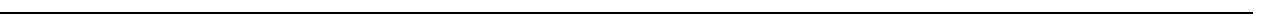
Fig. 2 USP48 cleavage rates on H2ABRCA1ub are modulated by an auxiliary ubiquitin. a An auxiliary ubiquitin activates USP48 processivity. Gel-based assay to measure USP48 cleavage of H2A BRCA1ub . TAMRA Ub was used as readout. Cleavage was recorded under several different substrate and enzyme concentrations. Four (stacked) gels are shown as an example (Supplementary Fig. 3 for all gels). b Quanti fi cation of ( a . Four out of 11 different conditions shown as an example (Supplementary Fig. 3 for full panel). Solid lines show fi t obtained by global fi tting of all 11 quanti fi ed time courses and binding data to the model de fi ned in e using Kintek Explorer . c USP48 binds with similar af fi nities to ubiquitinated and unmodi fi ed NCP. USP48 is titrated to 50 nM of unmodi fi ed NCP or NCP BRCA1ub and analyzed by native gel-shift assays. A Kd of 1 µ M is estimated. d USP48 binds nucleosomes of different ubiquitination status with the same af fi nities. Binding of USP48 to H2A BRCA1ub , H2A BRCA1ub1 , and unmodi fi ed nucleosomes measured by surface plasmon resonance. Nucleosomes were immobilized on the surface. Normalized RU values of 10 successive injections of different USP48 concentrations are fi tted by a one- phase binding model using GraphPad Prism (raw data in Supplementary Fig. 3b). K d and SE of the fi t are indicated. e USP48 cleaves H2A BRCA1ub in nucleosomes 50 – 150 times faster than when auxiliary ubiquitin is present. Kinetic model describing USP48 ’ s cleavage pattern on H2A BRCA1ub with the fi tted values for k k k fi t. f Parameters for k k k cat(ub3) , cat(ub2) , and cat(ub1) , and the SE of the cat(ub3) , cat(ub2) , and cat(ub1) in e are well constrained by the data. Evaluation of the goodness of fi t. The upper three panels show how well de fi ned the lower and upper boundaries are for the individual parameters. k cat(ub1) and k cat(ub2) fall into a well-de fi ned local χ 2 minimum. For k cat(ub3) , the lower boundaries are well de fi ned which allows the conclusion that K cat(ub3) should always be faster than k cat(ub1) . The lower panel shows how χ 2 varies when two of the fi tted variables are varied against each other. Red indicates a χ